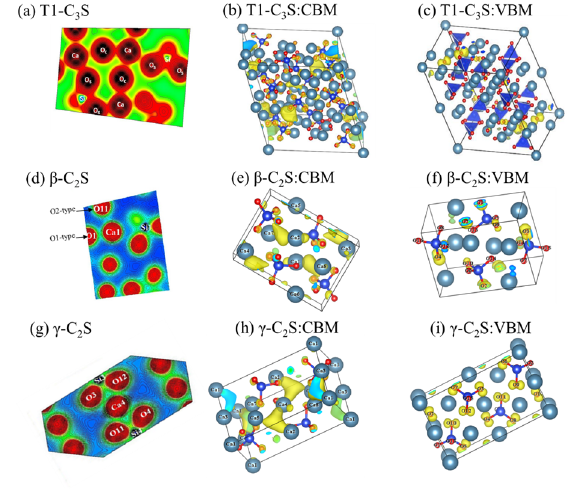
Figure 2. Charge density distribution and LDOS of VBM and CBM respectively for: (a) (b) and (c) T1 ‐ C3S; (d), (e) and (f) β‐ C2S; (g), (h) and (i) γ‐ C2S. Atomic color codes are oxygen: red, calcium: tourqois, silicon: blue [19,23]. Copyright 2019, 2021